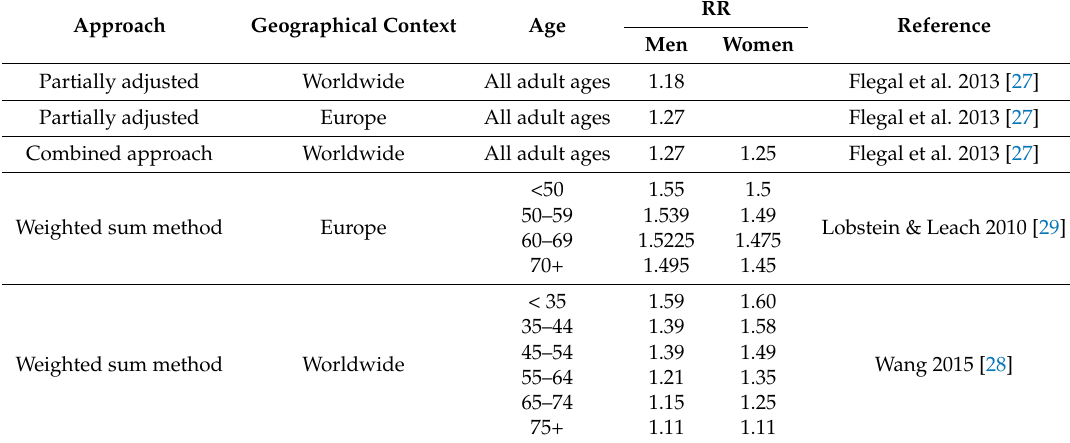
Table 2. RRs used in the all-cause approach and their characteristics.